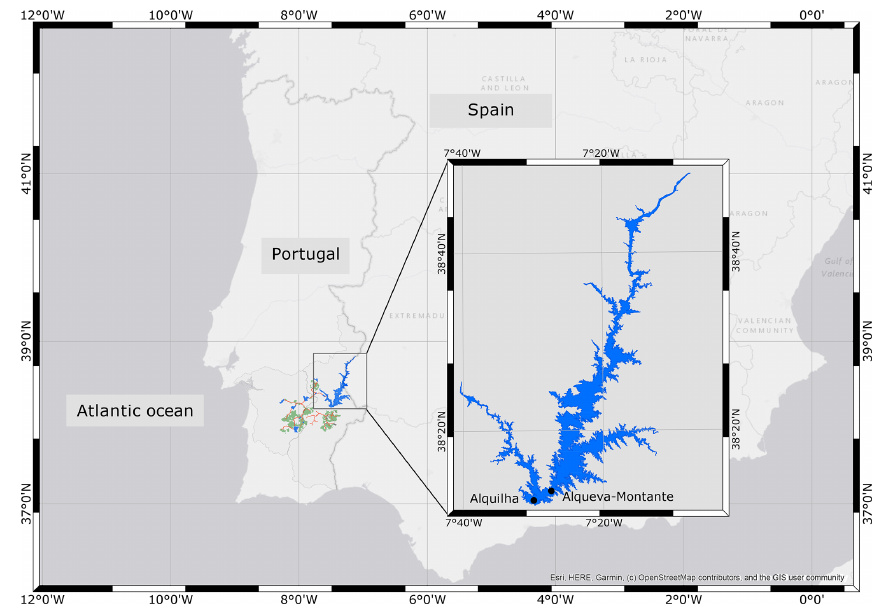
Figure 1. Multipurpose Alqueva Project (MAP) location. The expanded map is of Alqueva Reservoir, showing two meteorological stations: Alquilha and Alqueva-Montante.